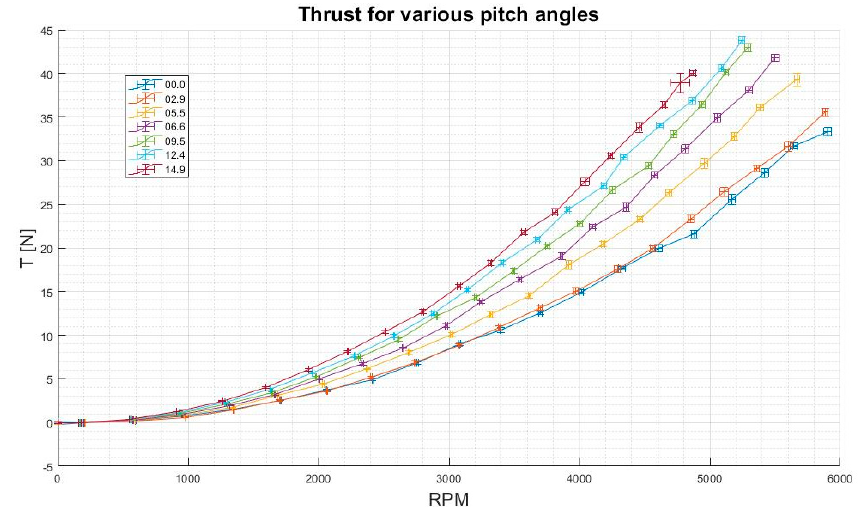
Figure 5. Thrust for various pitch angles.